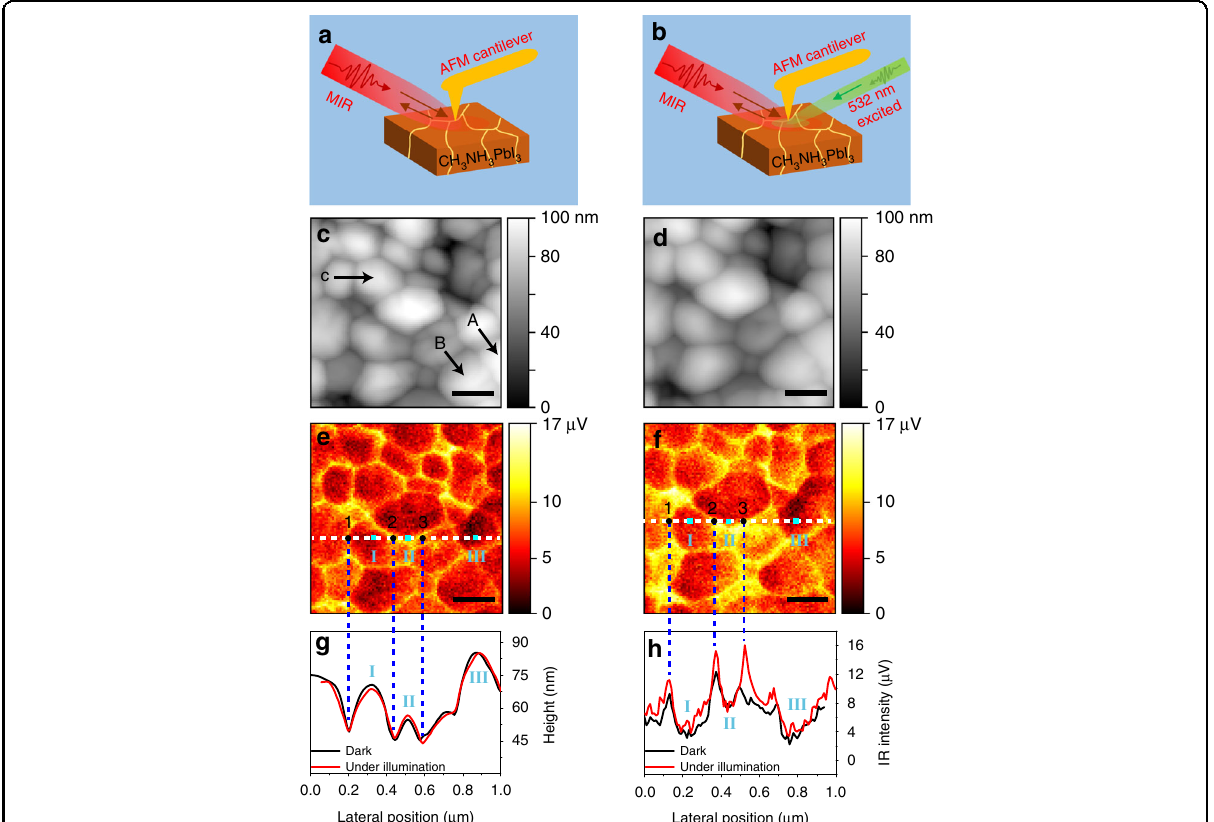
Fig. 2 Topography and infrared near- fi eld image in the dark and under illumination. a Schematic illustration of the s-SNOM setups in the dark and b with external illumination of a 532 nm laser; c AFM topography, and e the simultaneously acquired infrared near- fi eld image in the dark; d AFM topography and f infrared near- fi eld image in the same area under the illumination by 532 nm laser for 10 min. g and h are the one-dimensional topography and near- fi eld amplitude line pro fi les along the white dashed lines in e and f , respectively. Three locations of GBs are marked by black dots and numbered as 1, 2, 3 in e and f , whereas the cyan solid squares labeled by I, II, III mark three locations of IGs. The scale bars for all the images are 200